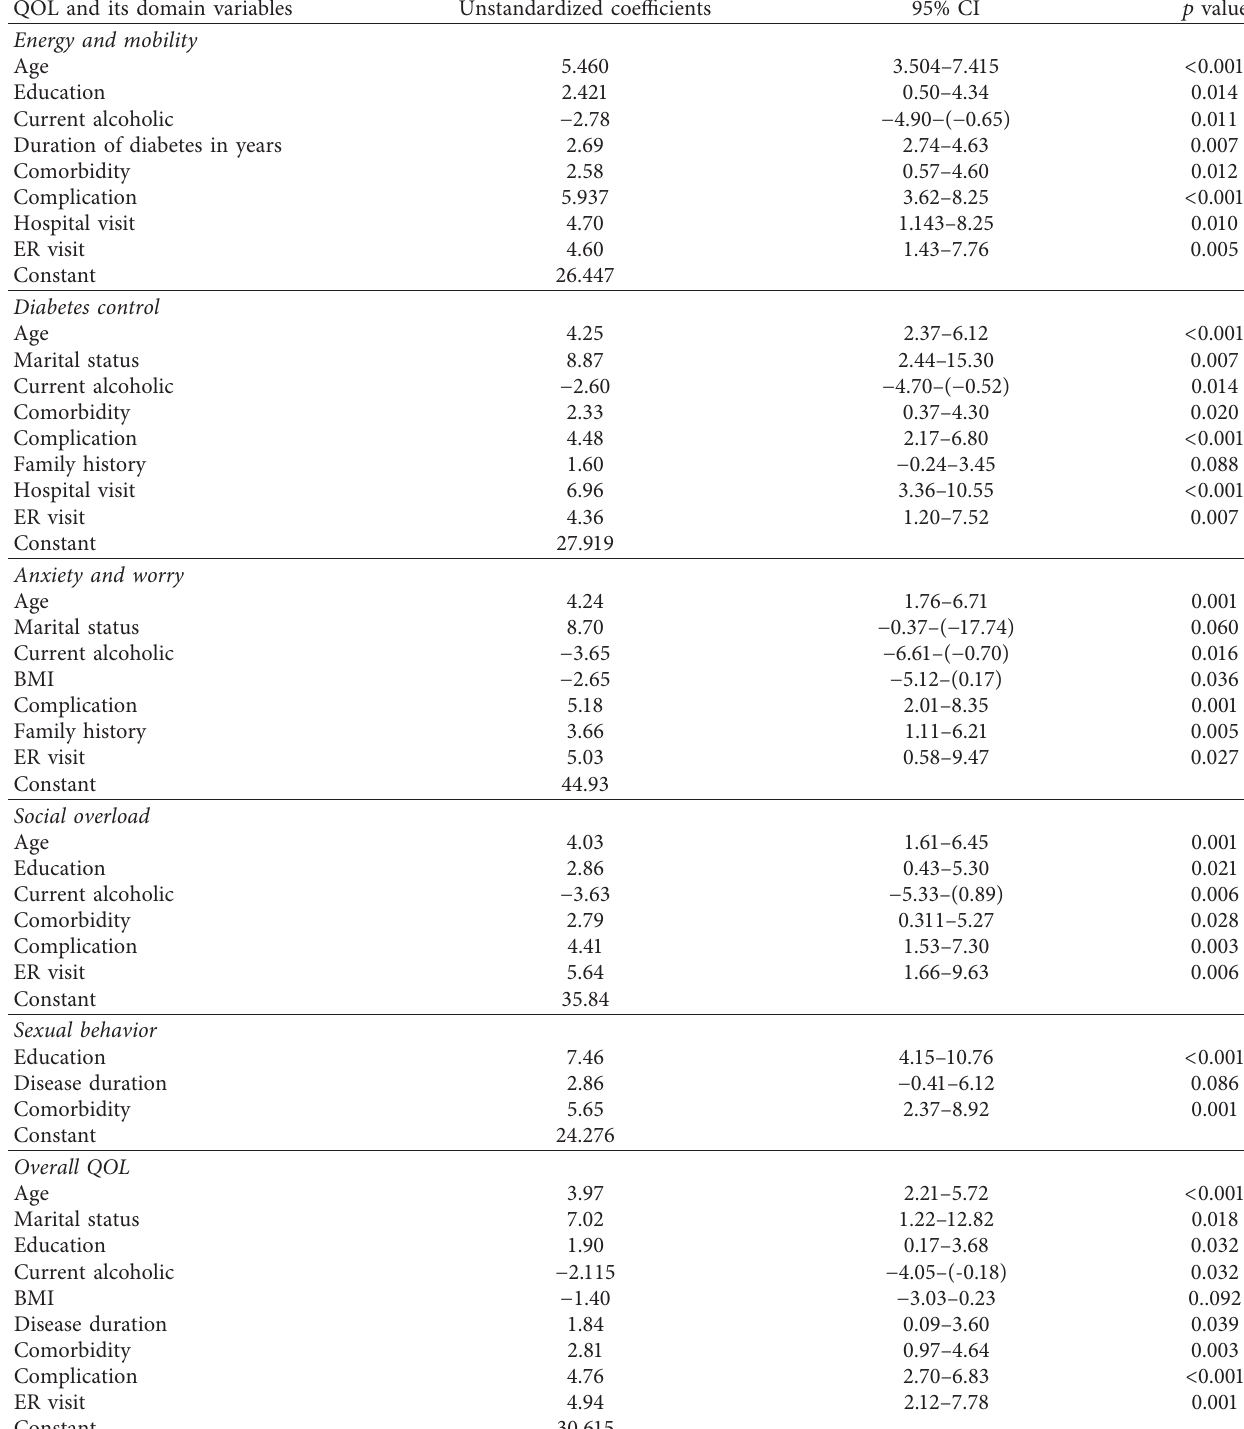
Table 4: Multiple linear regression analysis of significant factors associated with QOL and its